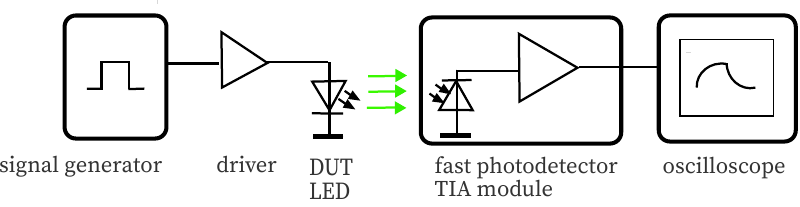
Figure 3. This drawing shows the setup for measuring the rise/fall time of LEDs used as light source. The source part of this setup has also been used for investigation of the temporal characteristics of the LEDs used as photodetector.